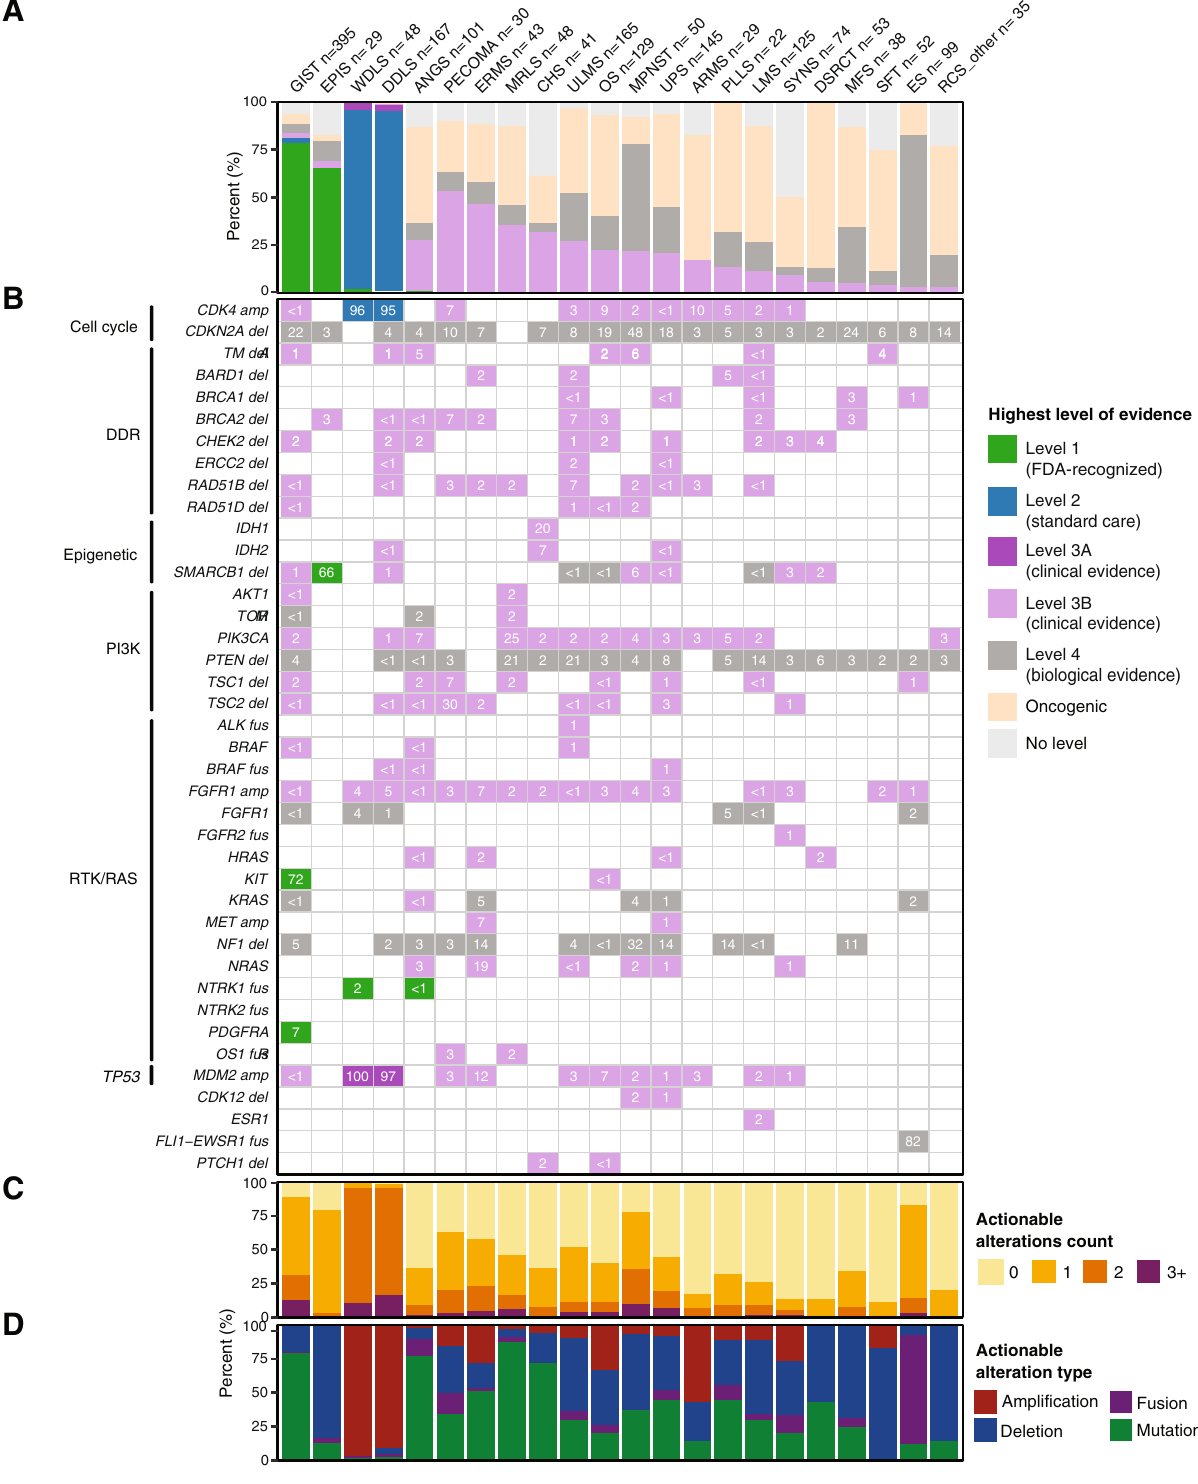
Fig. 6 Actionability of mutations by subtype and gene. For each of the 22 most common subtypes: A Frequency of actionable alterations by level of evidence. B Actionable alterations in individual genes, grouped by pathway. Numbers in each cell represent the percentage of samples with actionable alterations in that gene. C Number of actionable alterations per sample. D Frequency of actionable alterations classi fi ed by alteration